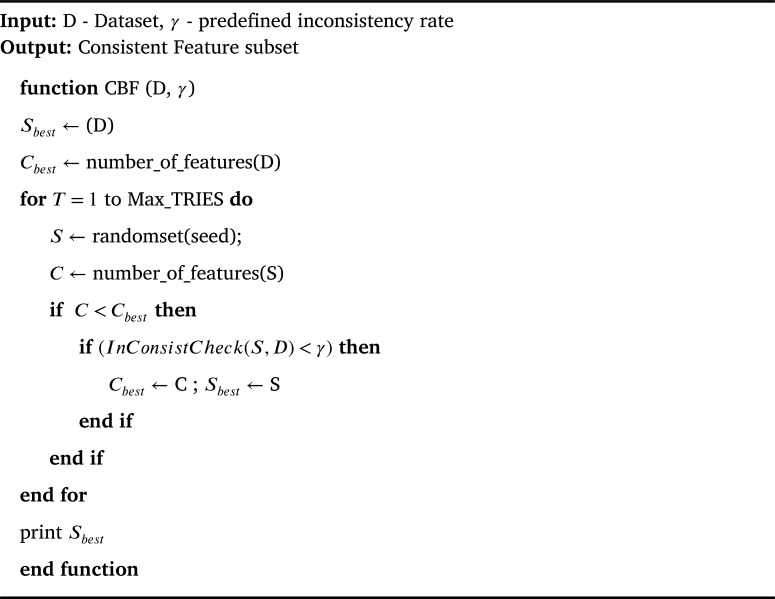
CBF Algorithm [29].